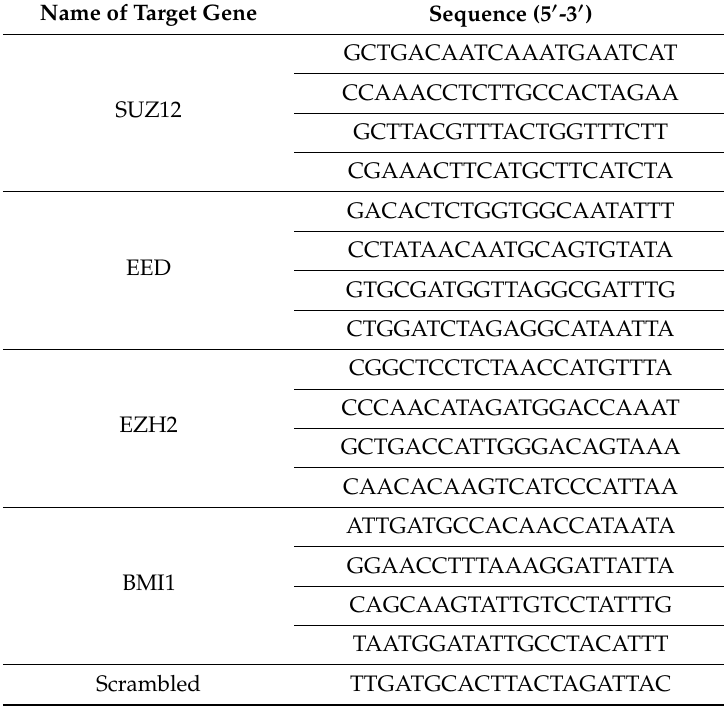
Table 1. List of sequences of siRNA, shRNA and